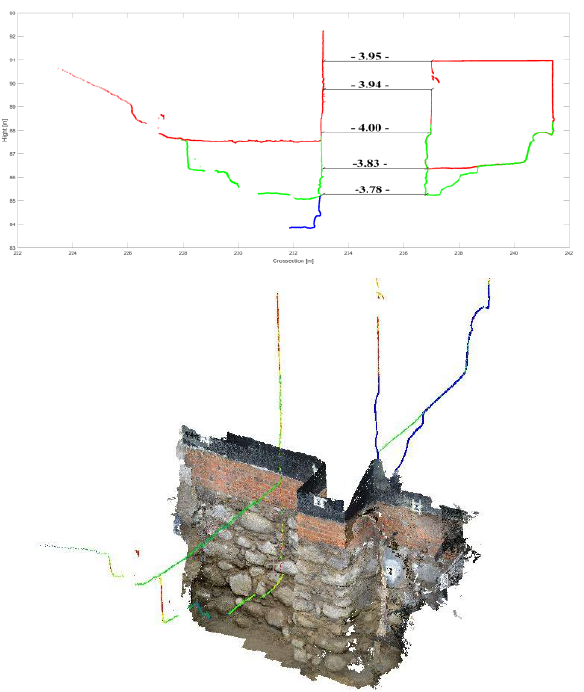
Figure 8. Example cross-section with marked